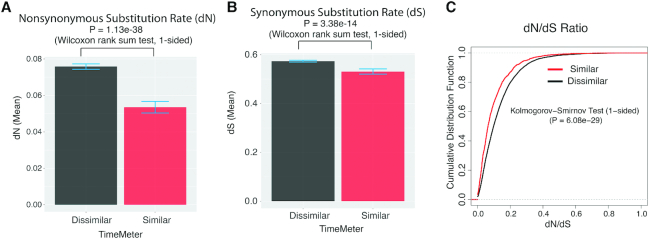
Nonsynonymous and synonymous substitution rates for temporally similar and dissimilar genes between human ES and mouse EpiS during neural differentiation. (A) Nonsynonymous substitution rate (dN). (B) Synonymous substitution rate (dS). (C) dN/dS ratio.